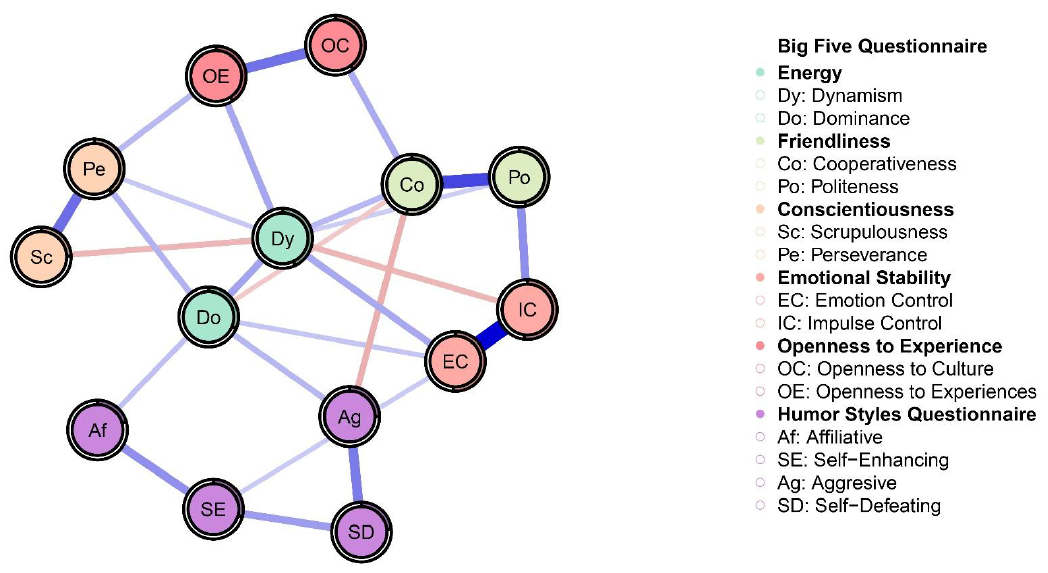
Figure 2. Network model for Humor Styles dimensions and Big Five Personality facets: Graphical representation ( n = 462). Note: In the network model, the Humor Style Questionnaire dimensions and the ten facets of the Big Five Questionnaire are represented by nodes. Links between nodes are displayed via edges. Positive connections are shown by blue edges, whereas negative connections are shown by red edges; the stronger the connection, the thicker the edge. The proportion of shared variation of each node with its surrounding nodes is shown as a pie chart around the nodes.